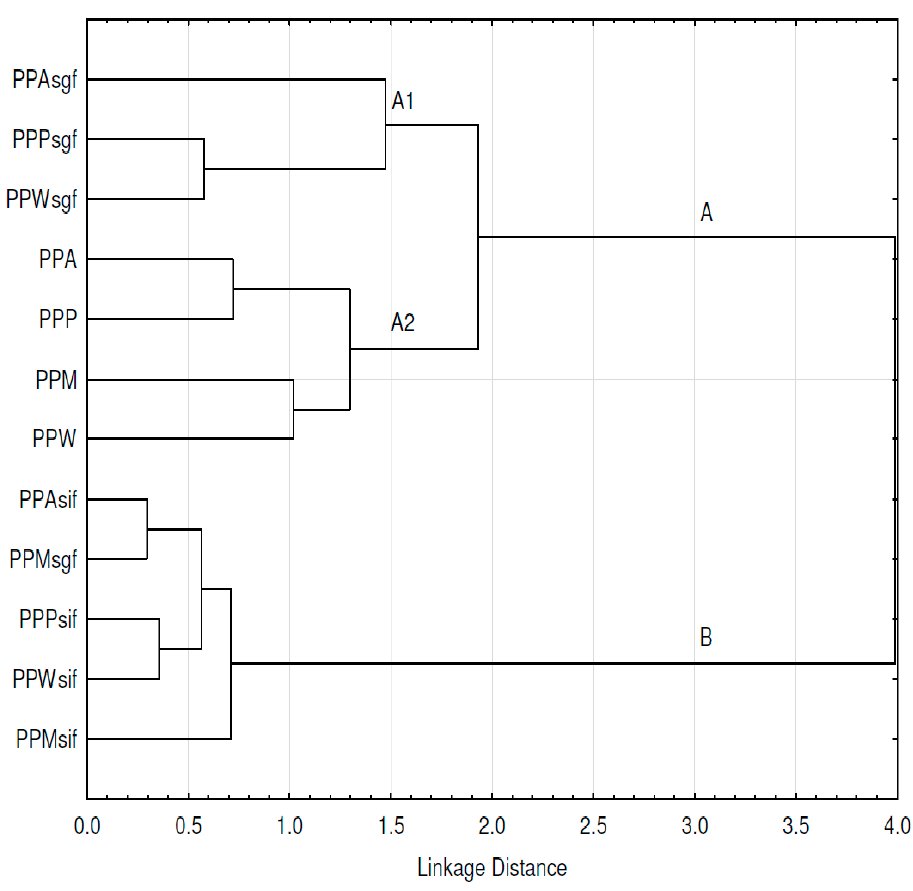
Figure 4. Dendrogram as a result of HCA analysis of determined bioactivity values .